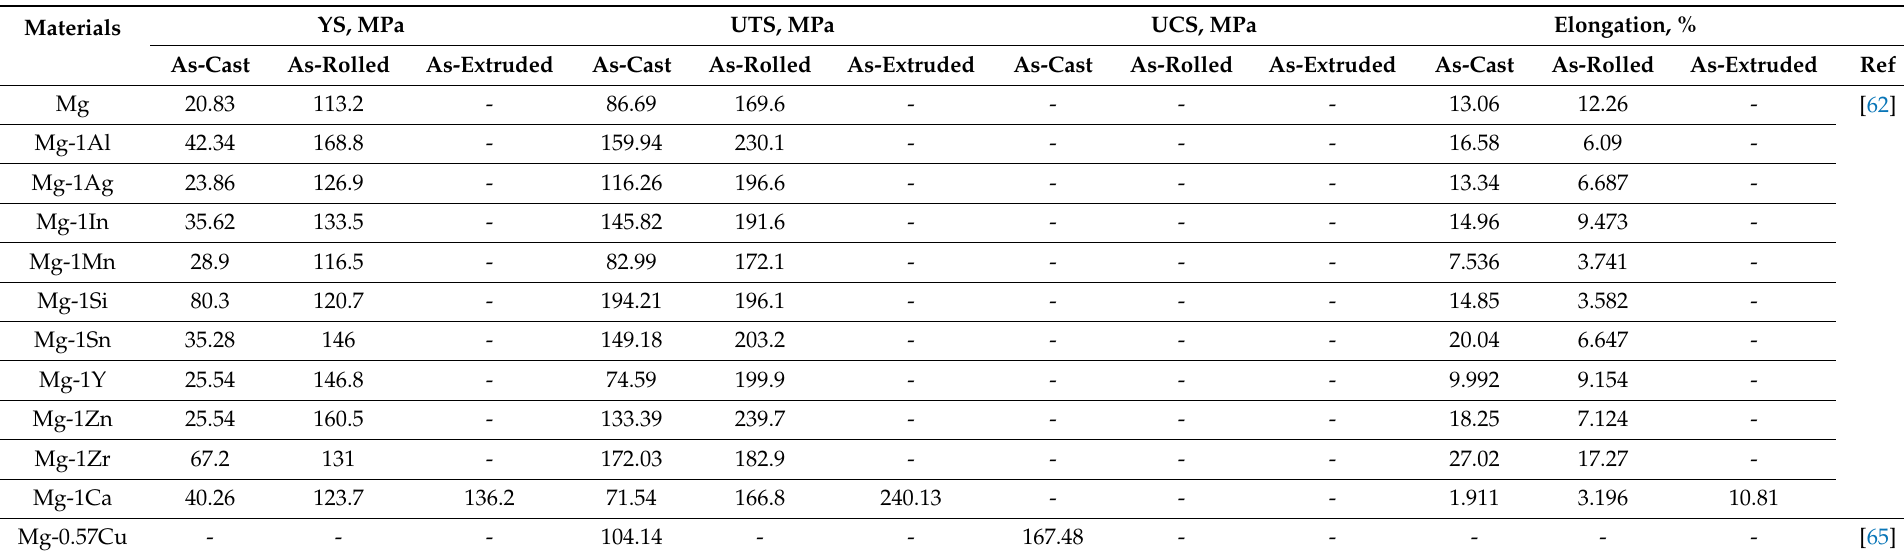
Table 5. A summary of the mechanical properties of some of the Mg binary alloys as reported in various